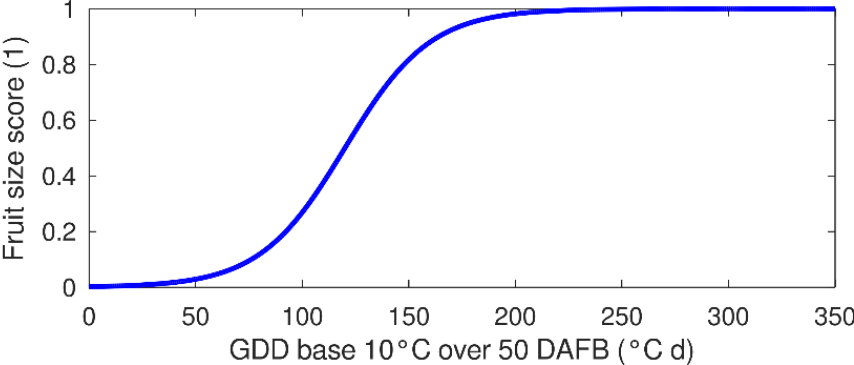
Figure 4 . Fruit-size score as a function of growing degree days (GDD) base 10 °C in the first 50 days after full bloom (DFB) for apple. A higher score indicates a larger